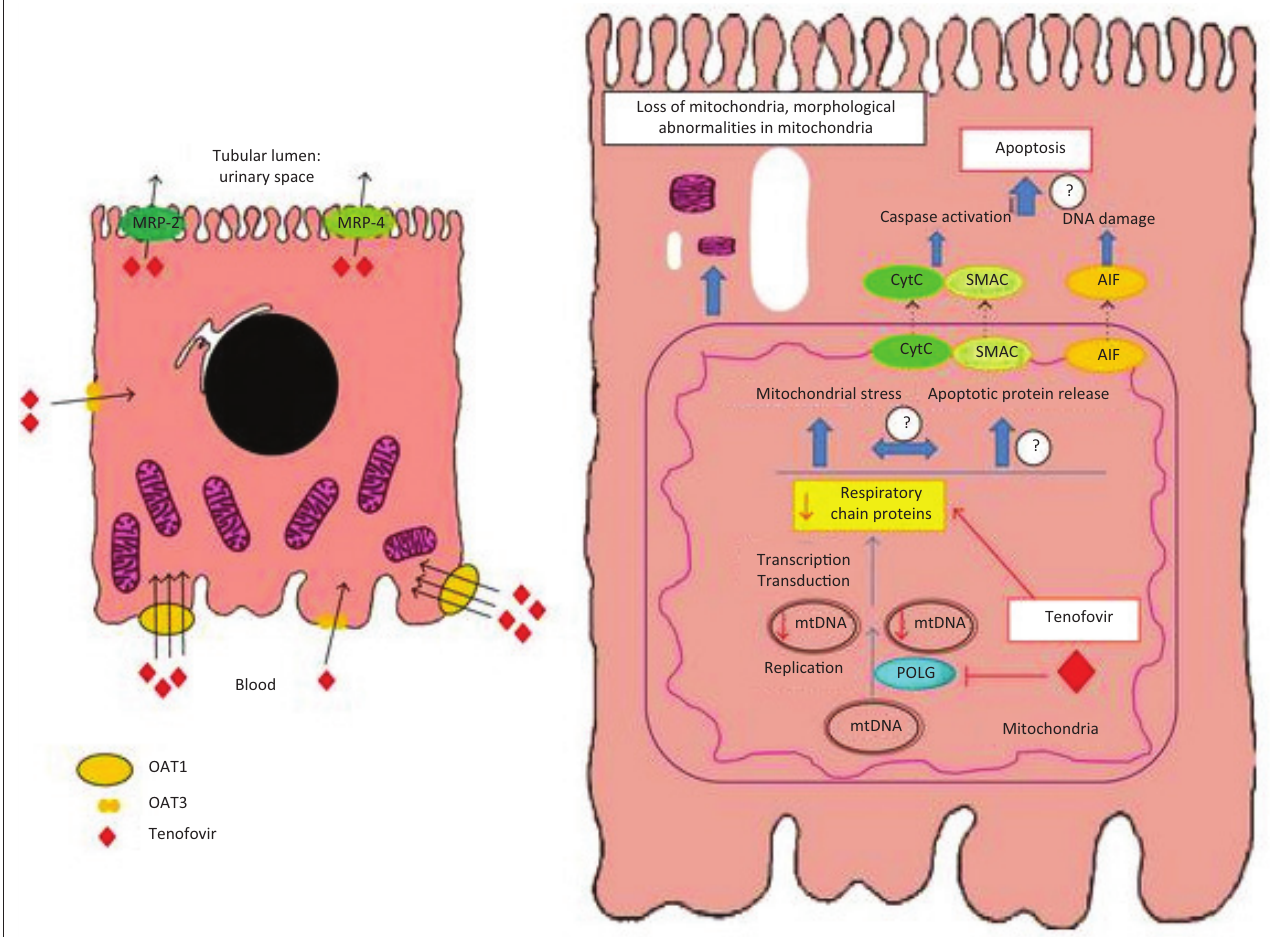
FIGURE 1: Tubular handling of